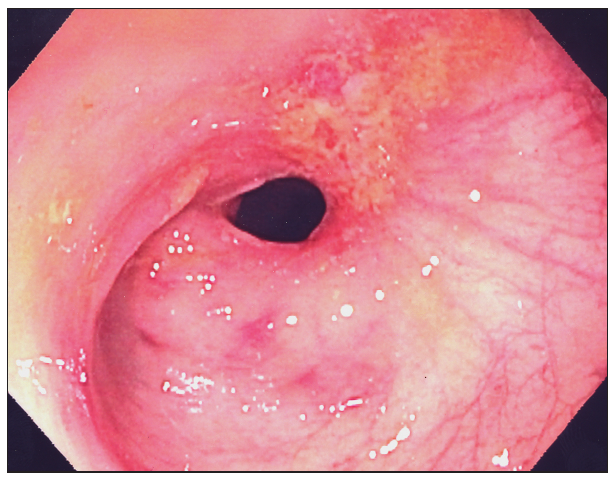
Figure 3) Endoscopic image. Stricture at 40 cm from the anal verge seen on colonoscopy after